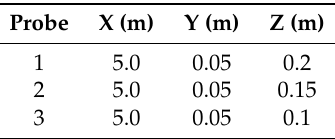
Table 2. Velocity probe positions for intermediate water